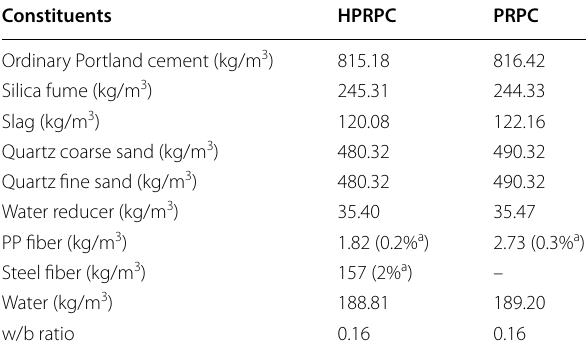
Table 2 Mixture design for HRPC and